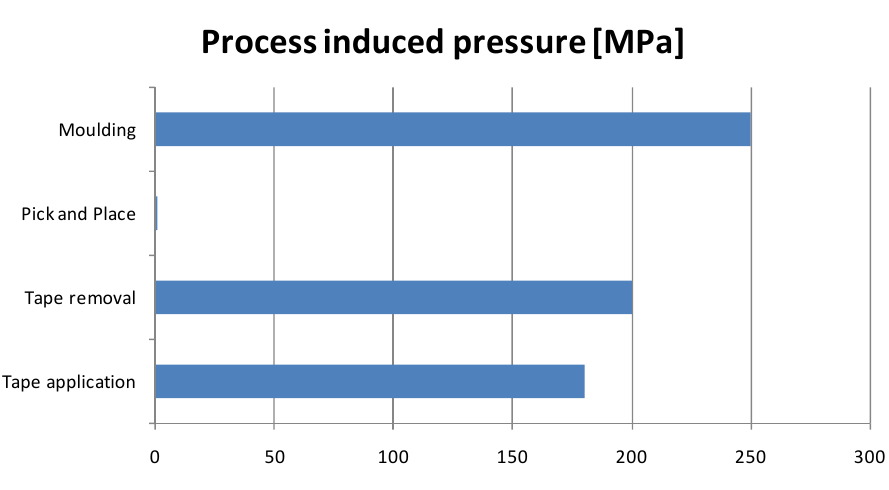
Figure 15. Process induced pressures on the